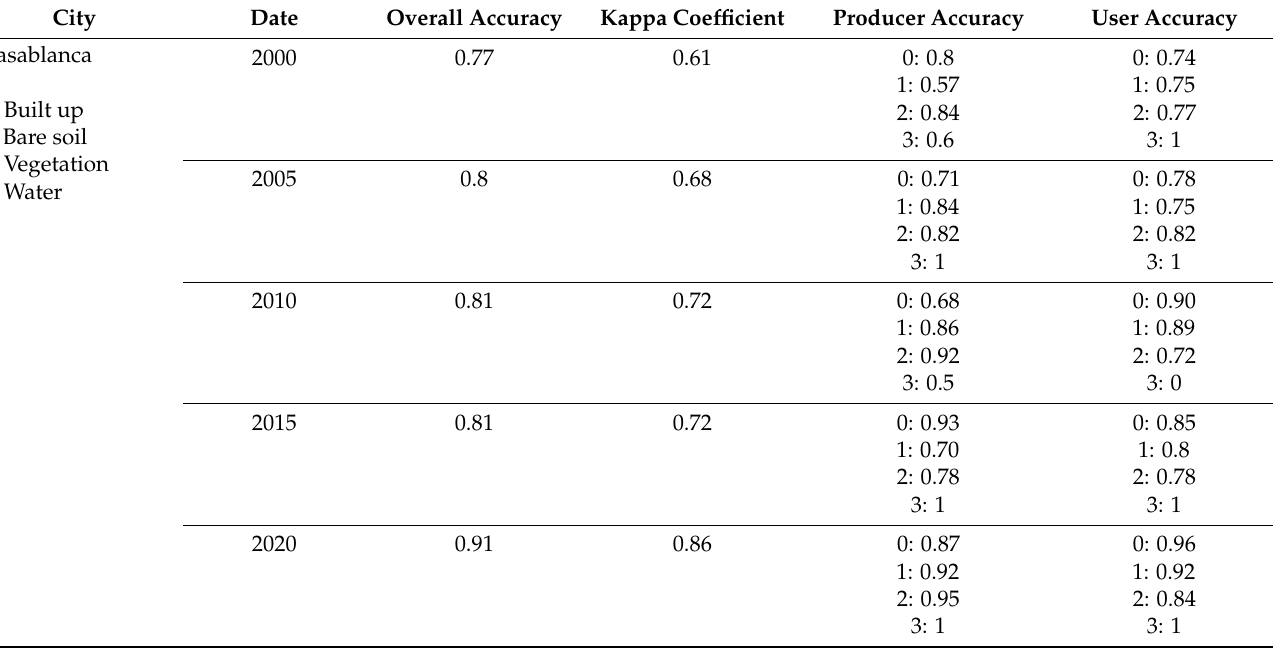
Table 5. Statistical metrics for classification of HLULC data, where 0: Built up, 1: Bare soil, 2: Vegetation, and 3: